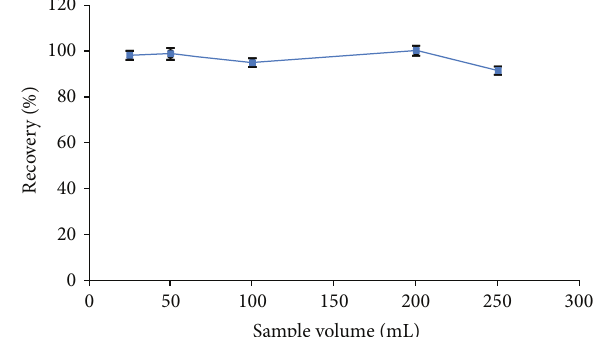
Figure 11: Effect of sample volume on the recovery of CV. Condi- tions: pH: 9, amount of CV: 1.25 𝜇 g CV, amount of sorbent: 15mg, eluent: glacial acetic acid, eluent volume: 1.0mL, and extraction time: